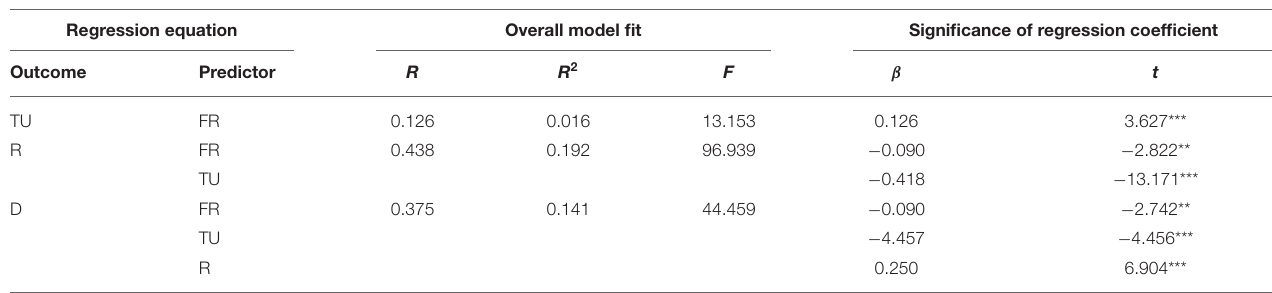
TABLE 2 | Regression analysis of the chain mediation model.